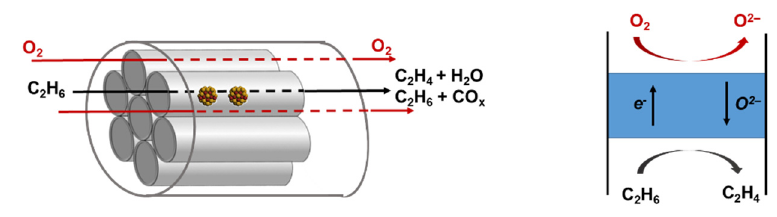
Figure 2. Scheme of a membrane reactor for oxidative dehydrogenation of ethane.